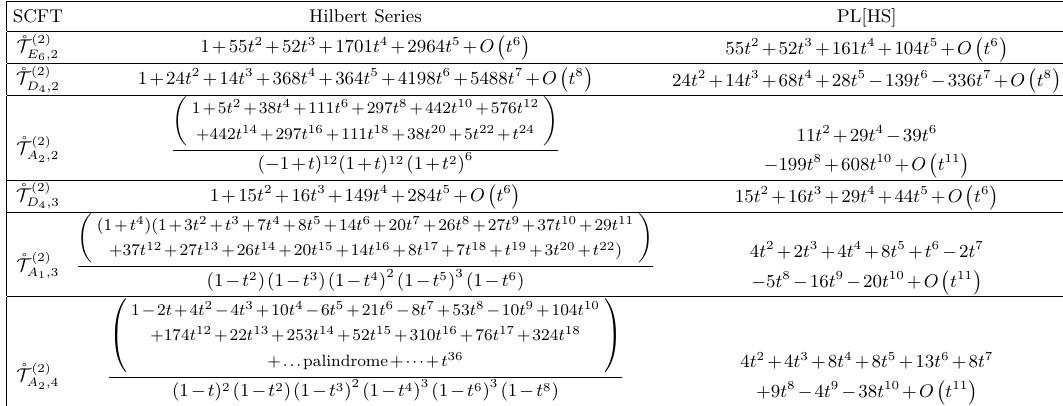
Table 14. Coulomb branch Hilbert series and plethystic logarithm for the magnetic quivers of ˚ theories in table 8. The unrefined PL confirms the dimension of the global T ( r =2) G,‘